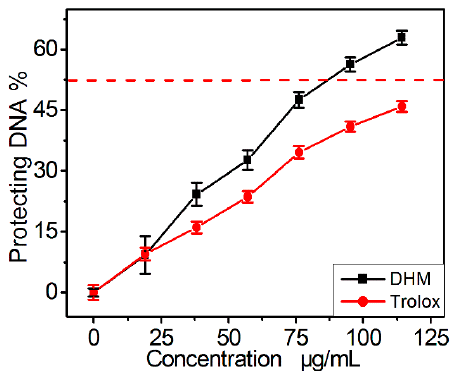
Figure 3. The protective effect of dihydromyricetin (DHM) against •OH-induced DNA damage in vitro. Each value is expressed as the mean ± SD ( n = 3).